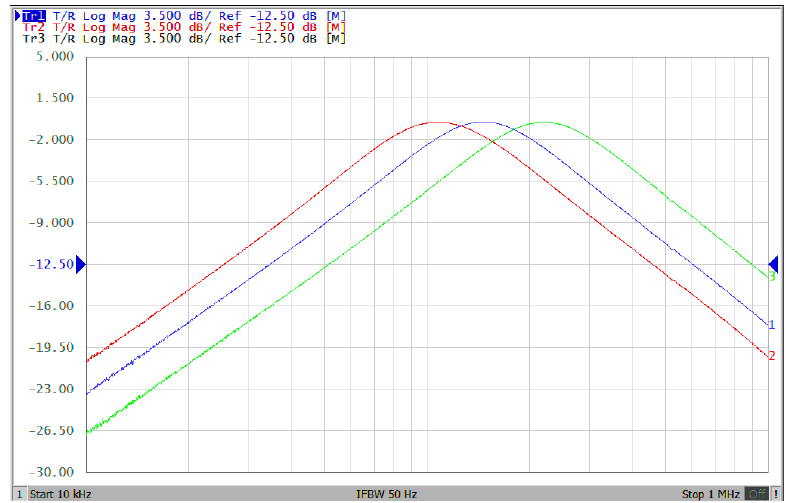
Figure 39. Experimentally observed gain responses of the BP filters realized by varying f o while keeping Q.